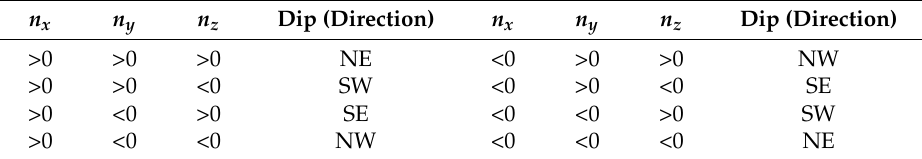
Table 1. The relation of the normal vector and the dip.